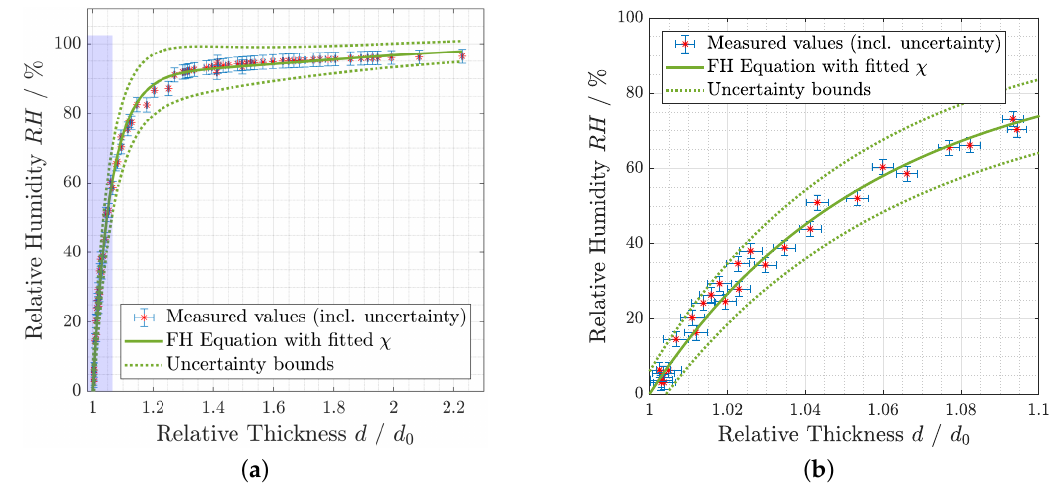
Figure 5. RH calculated with Flory–Huggins theory (Equation (1)) and the empirically determined Flory–Huggins parameter χ for a pHEMA thin film, compared with measured values. For a better visibility, ( b ) is the enlarged version of the blue shaded rectangle in ( a